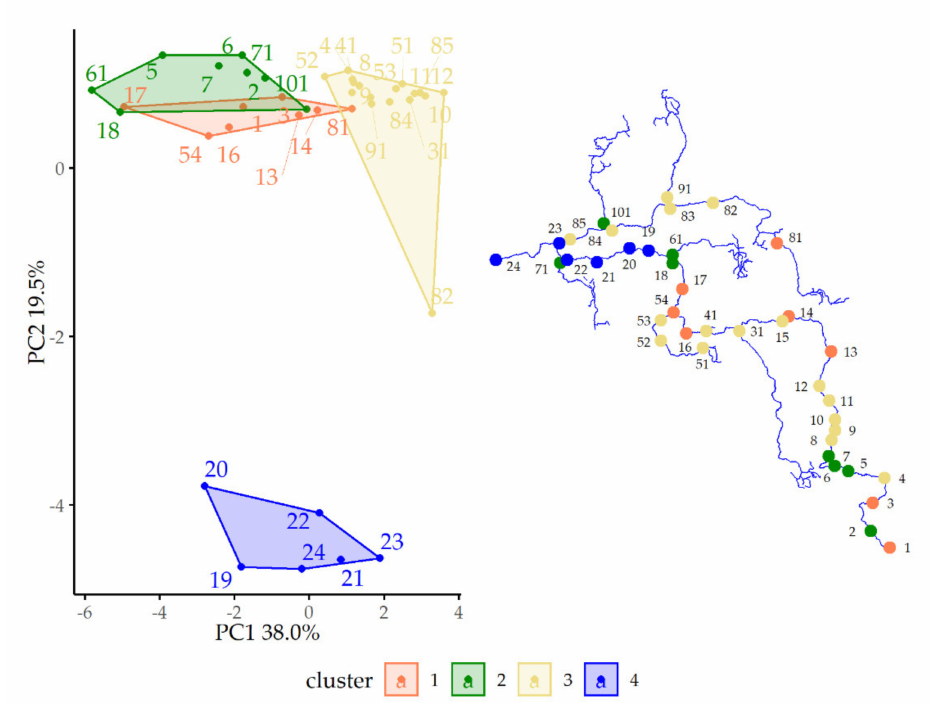
Figure 10. Classification of sampling points according to land